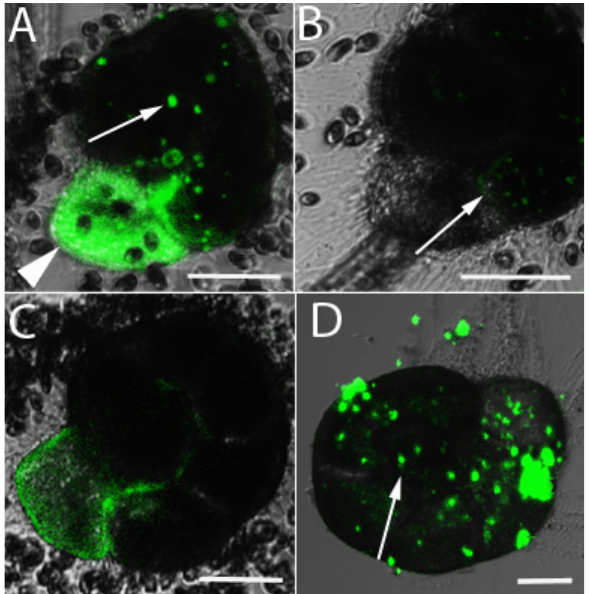
Fig. 1. Laser scanning confocal micrographs of three A. aomoriensis specimens after incubation in FITC-D-labeled seawater. (A) Specimen 1 was incubated in FITC-D labeled seawater for 3.5h prior to chamber formation. Immediately after the onset of chamber formation, the FITC-D was removed (see supporting information) and the image taken. Vesicles (ca. 20) were observed inside the cell (arrow). Due to remaining FITC-D-labeled seawater, which could not be washed out, fluorescence is seen inside the newly forming chamber (arrow head). This fluorescence diffuses out of the chamber within 15min. (B) Image of specimen 1 two hours after the first image (A) was taken. Chamber formation is almost completed. A few small vesicles are still present (arrow). (C) Image of specimen 2 immediately after chamber formation. Specimen 2 was incubated in FITC-D-labeled seawater during chamber formation. No vesicles are present. The new chamber is fluorescent. Note the difference between the fluorescence of the new chamber in (A) caused by remaining FITC-D-labeled seawater that diffused out within 15min and (C) due to FITC-D incorporated into the newly formed chamber. (D) Image of specimen 3 four hours after FITC-D incubation showing the highest number of vesicles (arrow) observed in this study. Before incubation the specimen was not fed for 48h. Scale bars are 40 µ m.